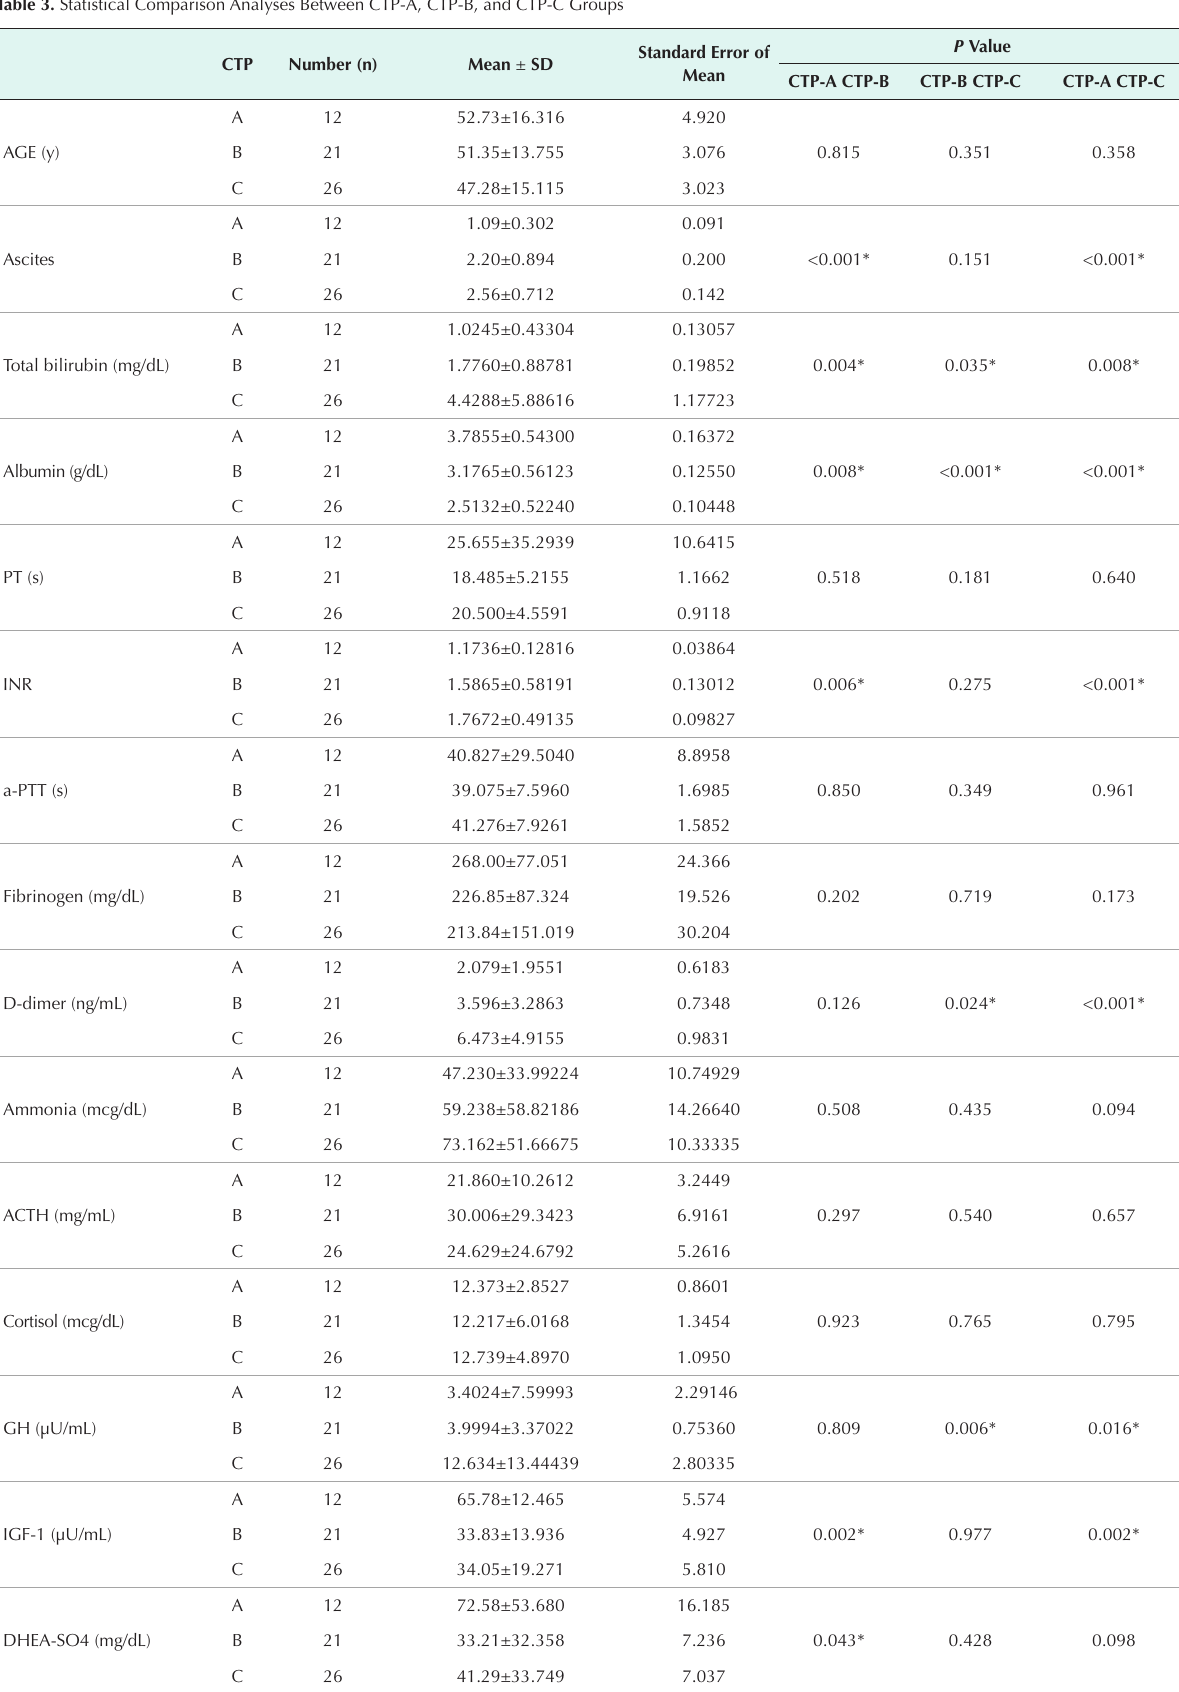
Table 3. Statistical Comparison Analyses Between CTP-A, CTP-B, and CTP-C Groups